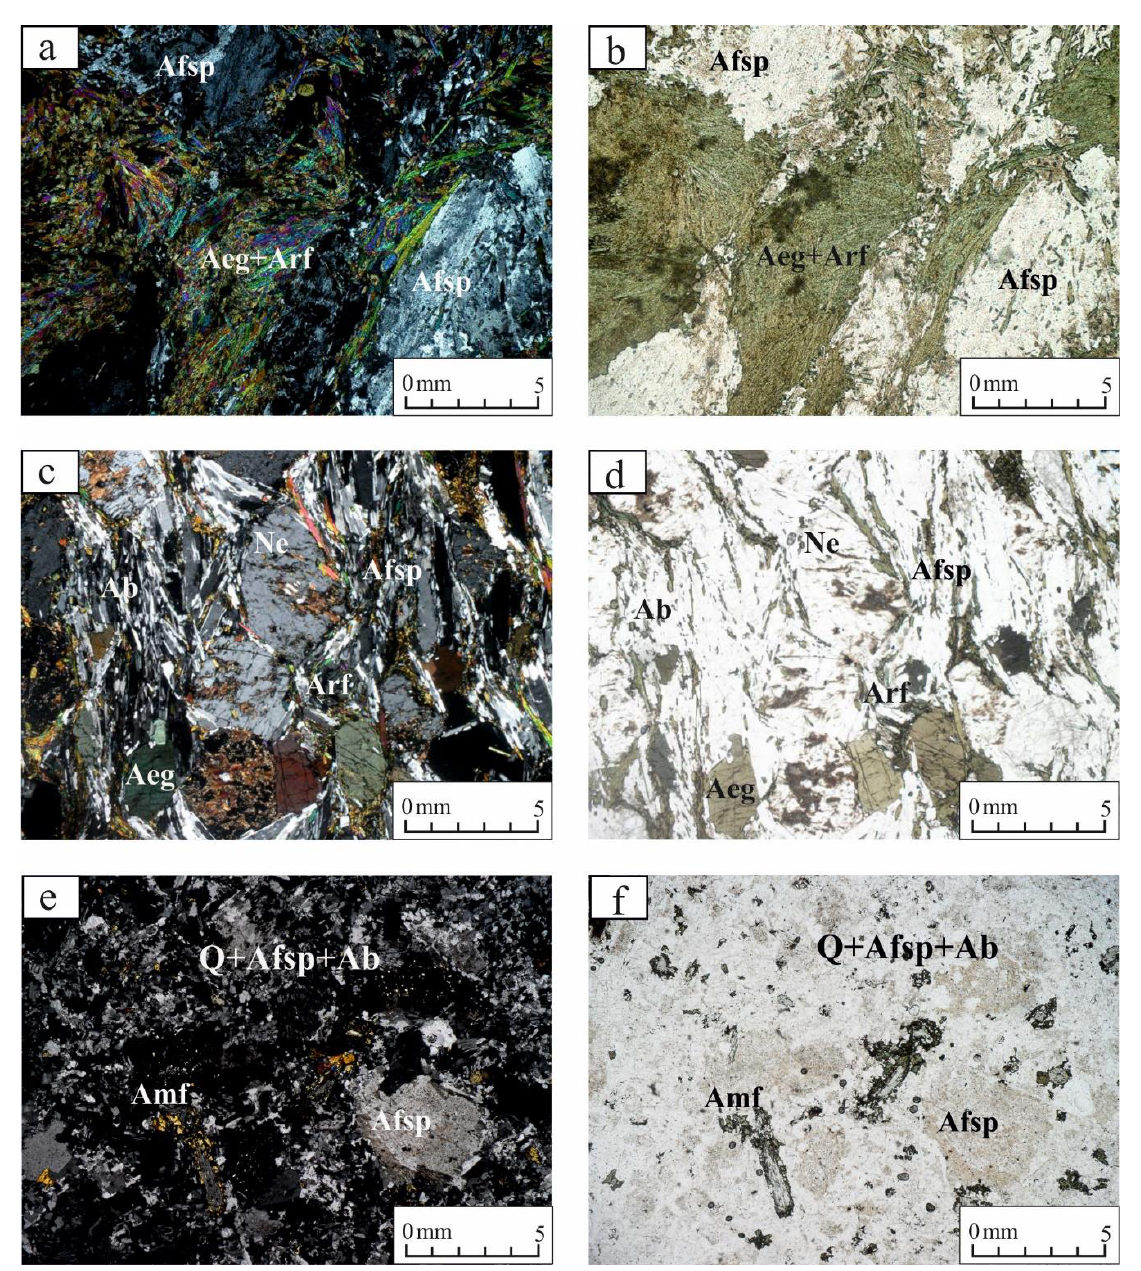
Figure 4. Micro-photos of representative thin sections: ( a , b ) quartz-free syenites, alkali feldspar undergoes albitization, aegirine and arfvedsonite form aggregate of needles; ( c , d ) foyaites, nepheline forms large crystals and xenomorphic grains between aegirine and alkali feldspar; ( e , f ) granites are composed of lamellar alkali feldspar, quartz–alkali feldspar–albite aggregate, and rare amphibole crystals. Left column: crossed polars, right column: parallel polars. Ne = nepheline, Aeg = aegirine, Arf = arfvedsonite, Amf = amphibole, Afsp = alkali feldspar, Ab = albite, Q = quartz.